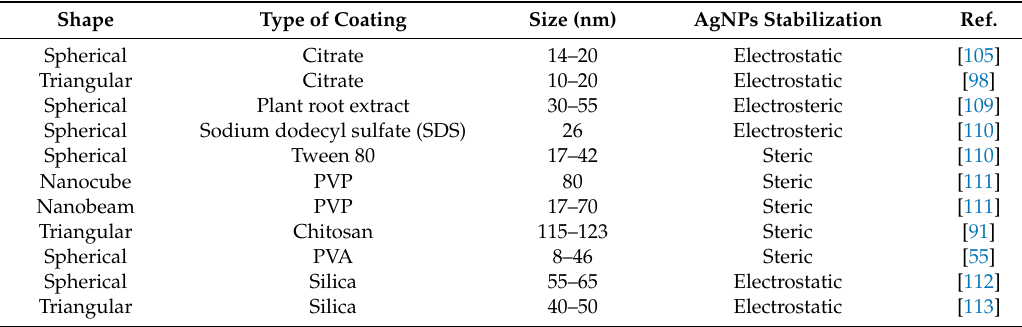
Table 2. Correlation between the coating nature and AgNPs stabilization mode.